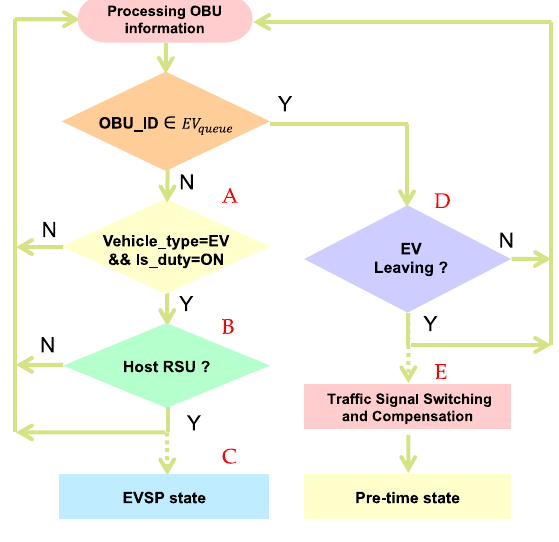
Figure 6. EVSP algorithm.